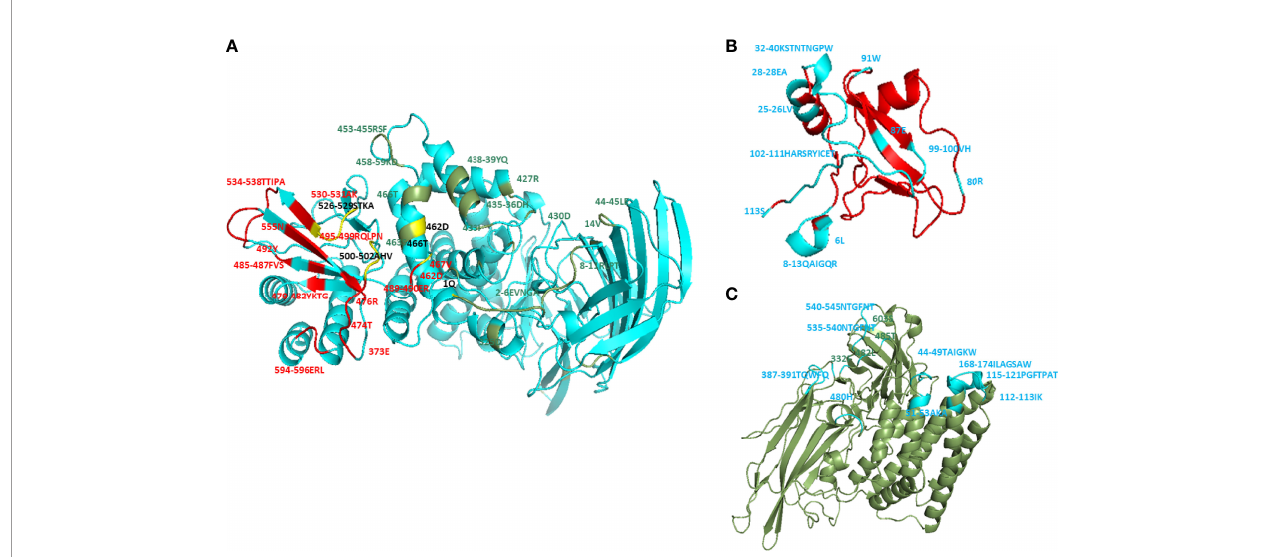
FIGURE 1 | Molecular docking of wt CTLGA9 and Cry11Aa with APN. Three dimensional structures were modeled using Phyre-2 engine and molecular docking was performed by Discovery Studio 2.5. (A) Residues in APN that are involved in interaction with Cry11Aa (colored in green), with CTLGA9 (colored in red), or with both Cry11Aa and CTLGA9 (colored in yellow). (B) Residues (blue color) in CTLGA9 involved in binding with APN receptor. (C) Residues (blue color) in Cry11Aa involved in binding with